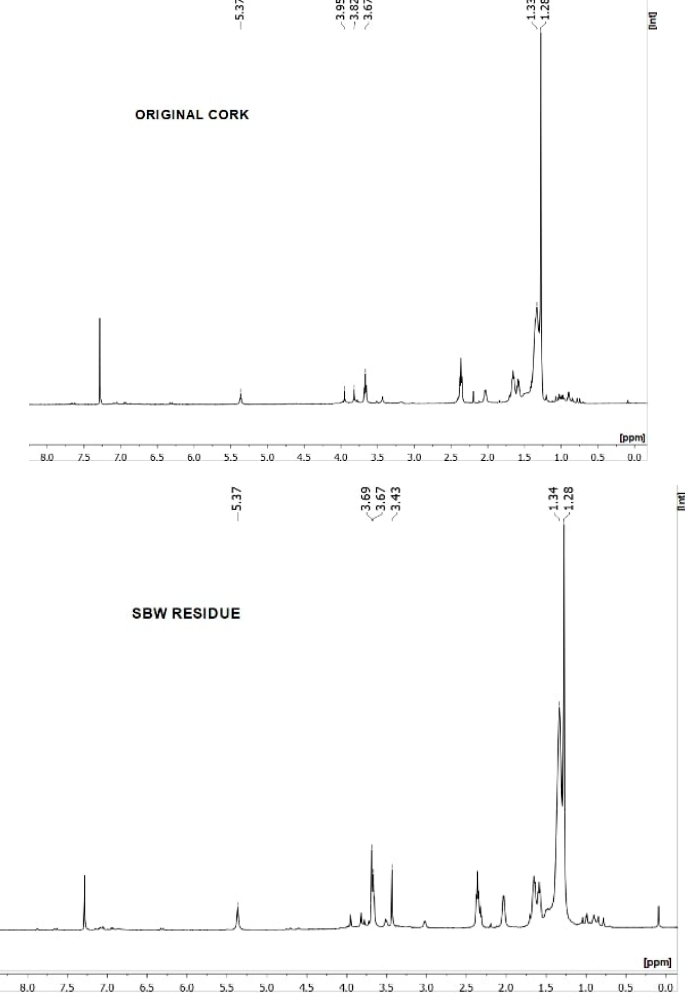
Figure 2. 1 H NMR spectra of the suberin monomers of granulated cork, before and after the SBW treatment, in deuterated chloroform (CDCl 3 ).